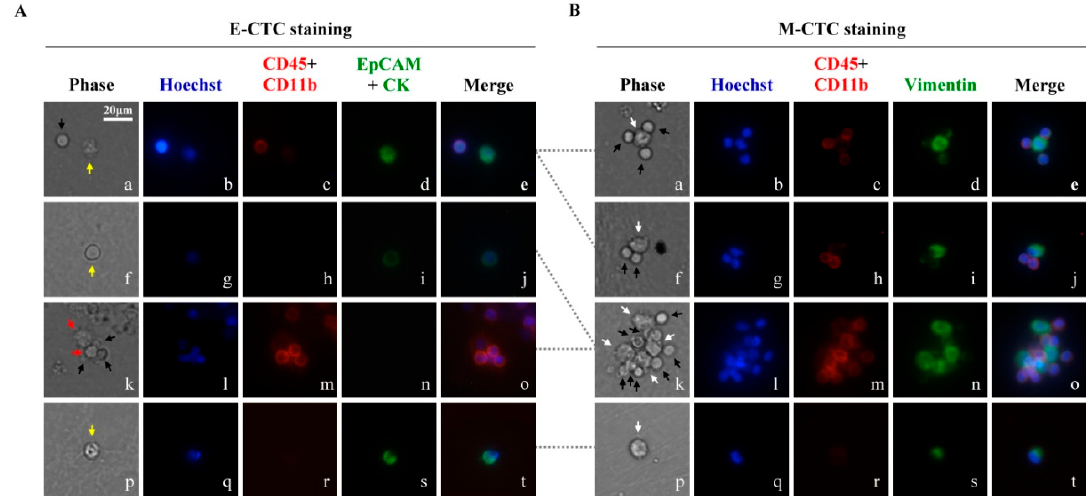
Figure 2. The results of immunofluorescence staining of 8-days cultures. The cultures were divided dichotomously and introduced into E-CTCs staining ( A ) and M-CTCs staining ( B ), respectively. Cells from the same patient were connected with gray dotted-line. Yellow arrows indicate E-CTCs (Hoechst pos /CD45 ∪ CD11b neg /EpCAM ∪ CK pos cells); White arrows indicate M-CTCs (Hoechst pos /CD45 ∪ CD11b neg /VIM pos cells); Black arrows indicate WBCs (Hoechst pos /CD45 ∪ CD11b pos cells); Red arrows indicate the cells which were positive for Hoechst staining and negative for the other immunofluorescent dye staining. Scale bar: 20 μ m.